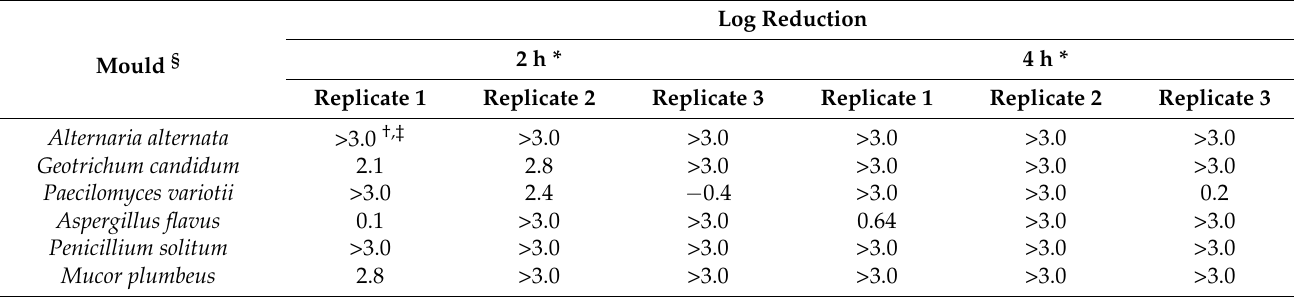
Table 2. Fungicidal effect of H 2 O 2 mist disinfection against mould spores dried on stainless